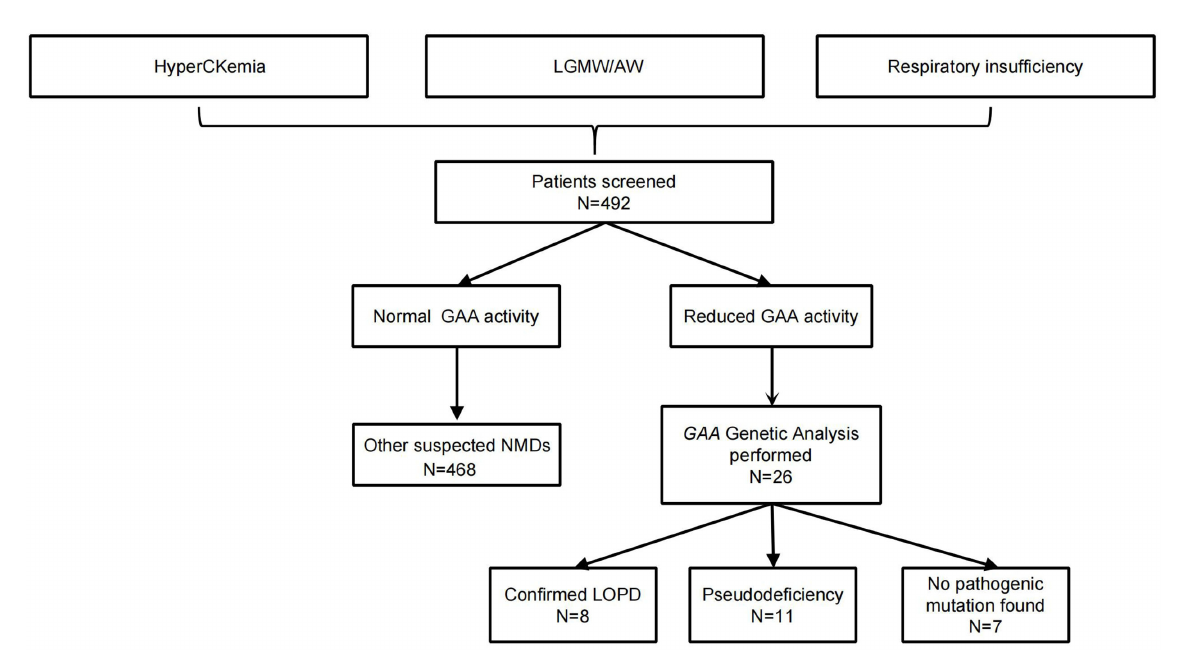
FIGURE1 A flow diagram of the study design and analysis. AW, axial muscle weakness; GAA, acid α -1,4-glucosidase; LGMW, limb-girdle muscle weakness; LOPD, late-onset Pompe disease; NMDs, neuromuscular disorders.